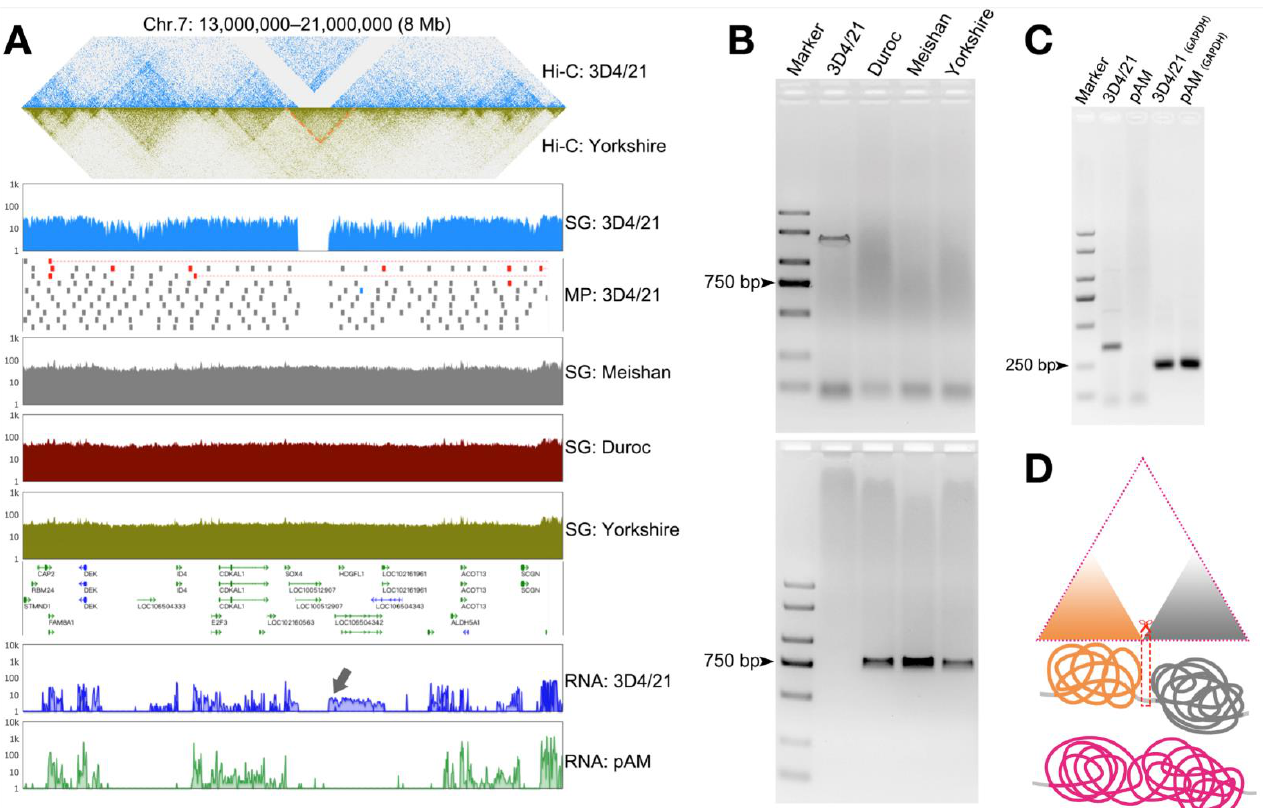
Figure 5. The effects of structural variation in 3D4/21 cells. ( A ) Visual integration for Chr7: 13,000,000 – 21,000,000 in 3D4/21 cells, showing the example of deletion leading to changes in the three-dimensional structure of chromatin and thus affecting gene transcription. Orange highlights changes in the 3D chromatin structure of 3D4/21 cells relative to Yorkshire pigs. The black arrow points to changes in 3D4/21 cells relative to the PAMs transcript. ( B ) 3D4/21 cells’ specific deletion in ( A ) was verified by PCR amplification, with primer locations corresponding to external ends of the deletion site (top) and inside of the deletion site (bottom). Lanes 1–5 are the same as above. ( C ) PCR amplification was used on cDNA to verify the difference between the 3D4/21 cells and PAMs transcripts, with primer (F6/R6) locations corresponding to the gray arrow in ( A ). Marker, DL2000. Lanes 2–3 correspond to transcription amplification of selected locations of 3D4/21 cells cDNA and PAMs cDNA. Lanes 4–5 correspond to GAPDH . The detailed primer sequences are shown in Table S3. ( D ) The schematic of deletion reshapes the genome structure of 3D4/21 cells. Red scissors correspond to the deletion position, orange and gray mean different TAD, and purple means fused